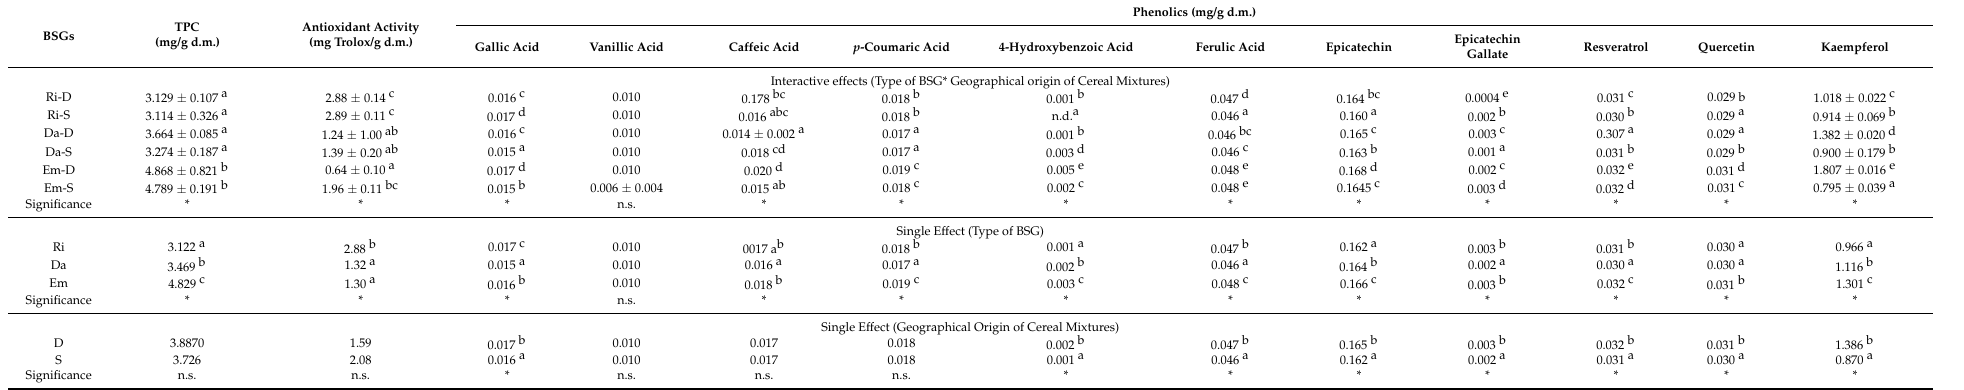
Table 4. Effects of type of BSG and geographical origin of the cereal mixtures used in brewing on phenolic contents and antioxidant activity of BSGs. BSGs TPC (mg/gd.m.) Interactiveeffects(TypeofBSG*GeographicaloriginofCerealMixtures) Ri-D